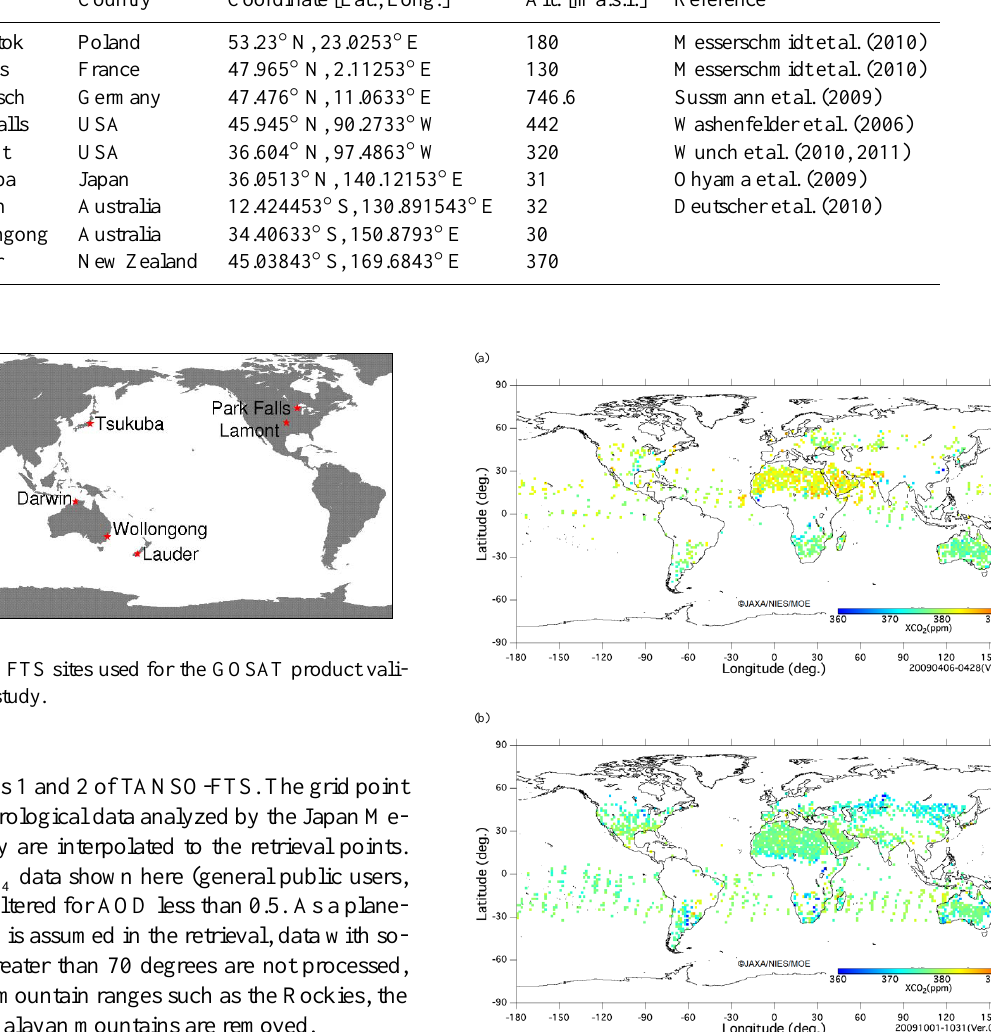
Fig. 2. Global distribution of GOSAT SWIR X CO monthly in 1.5 by 1.5 degree bins for (a) April and (b) October in